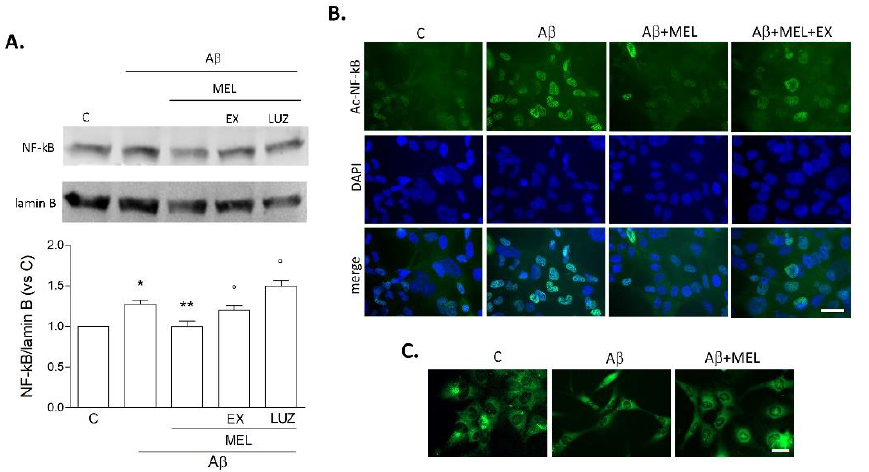
Figure 6. Pro-inflammatory switch of HMC3 cells upon prolonged A β 42 exposure. Cells were treated for 72 h with A β 42 alone (0.2 µ M), in combination with melatonin (MEL, 1 µ M), MEL+EX527 (EX; 5 μM), or MEL+luzindole (LUZ; 25 μM). In ( A ), Western blot of NF-kB p65 on nuclear fractions. Results are the mean ± SEM of three independent experiments, and a representative blot is shown. * p < 0.05 vs. C, ** p <0.05 vs. A β , ° p<0.05 vs. A β +MEL by one-way ANOVA followed by Newman–Keuls test for significance. In ( B) , representative images of immunostaining for acetyl-Lys310-NF-kB p65 (green) with DAPI counterstaining (blue; scale bar = 40 μm). In ( C ), morphological appearance of cells stained with fluorescent dye FM 1–43 (5 μ M for 15 min; scale bar = 50 μm).